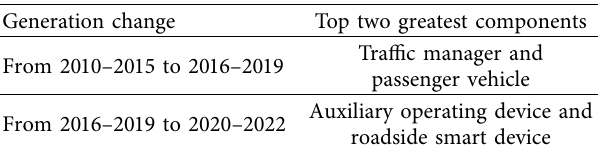
Figure 8: Transport vehicle, station infrastructure, and drivers are all in the top three components. Te driver becomes the second component in 2020–2022. Table 4: Sorted by the weight of words, the top two components of connotation change between the two generations.